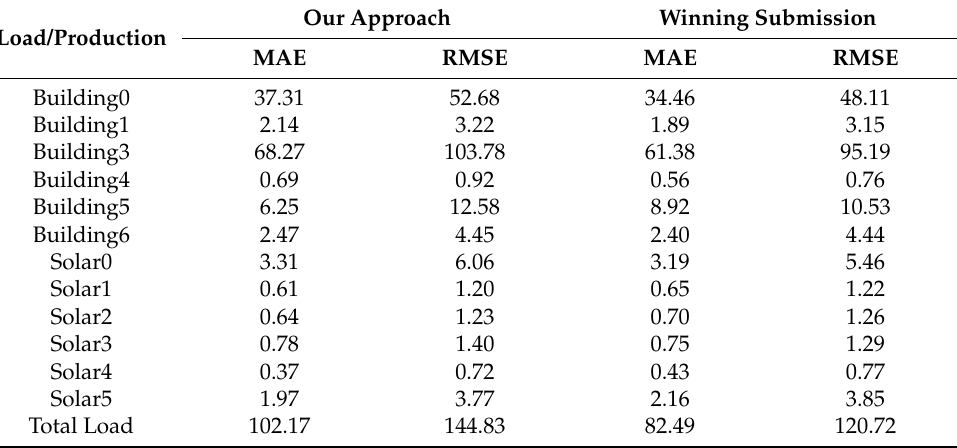
Table 2. Mean absolute error (MAE) and root mean squared error (RMSE) of predictions of individual loads/productions and total load, as determined by our approach and the winning submission of the